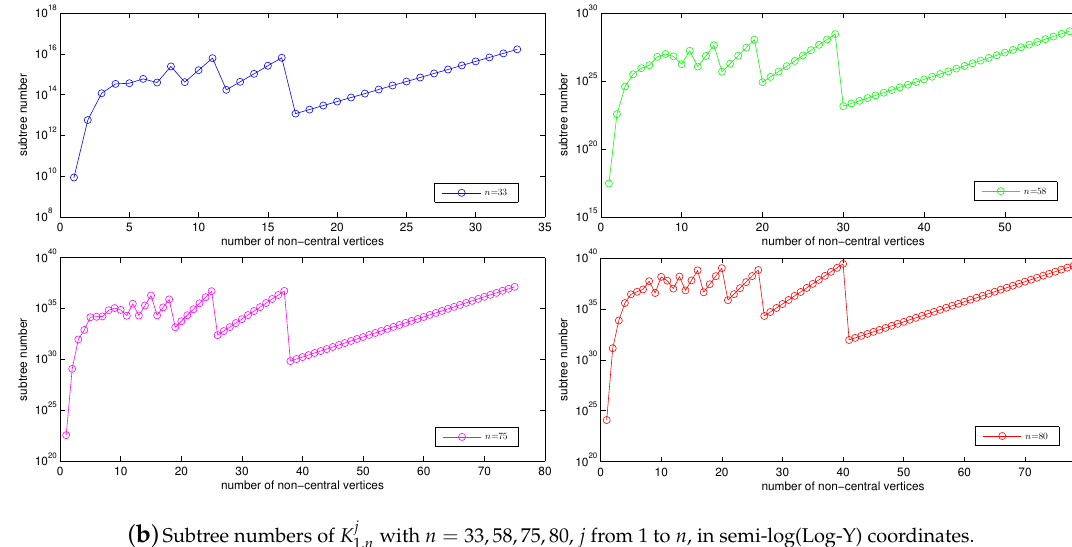
Figure 4. Subtree numbers of K j